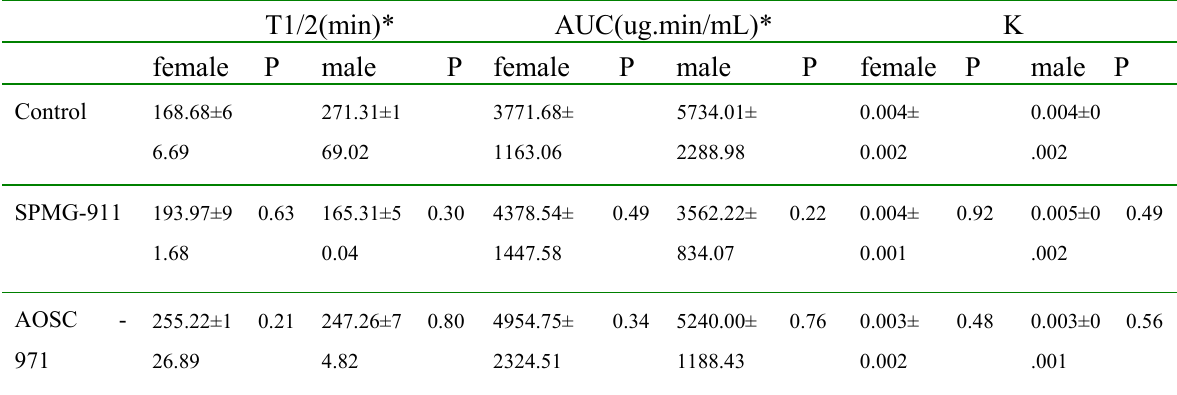
Table 1. Pharmacokinetic Data of Caffeine ( 5, =± nsx ).